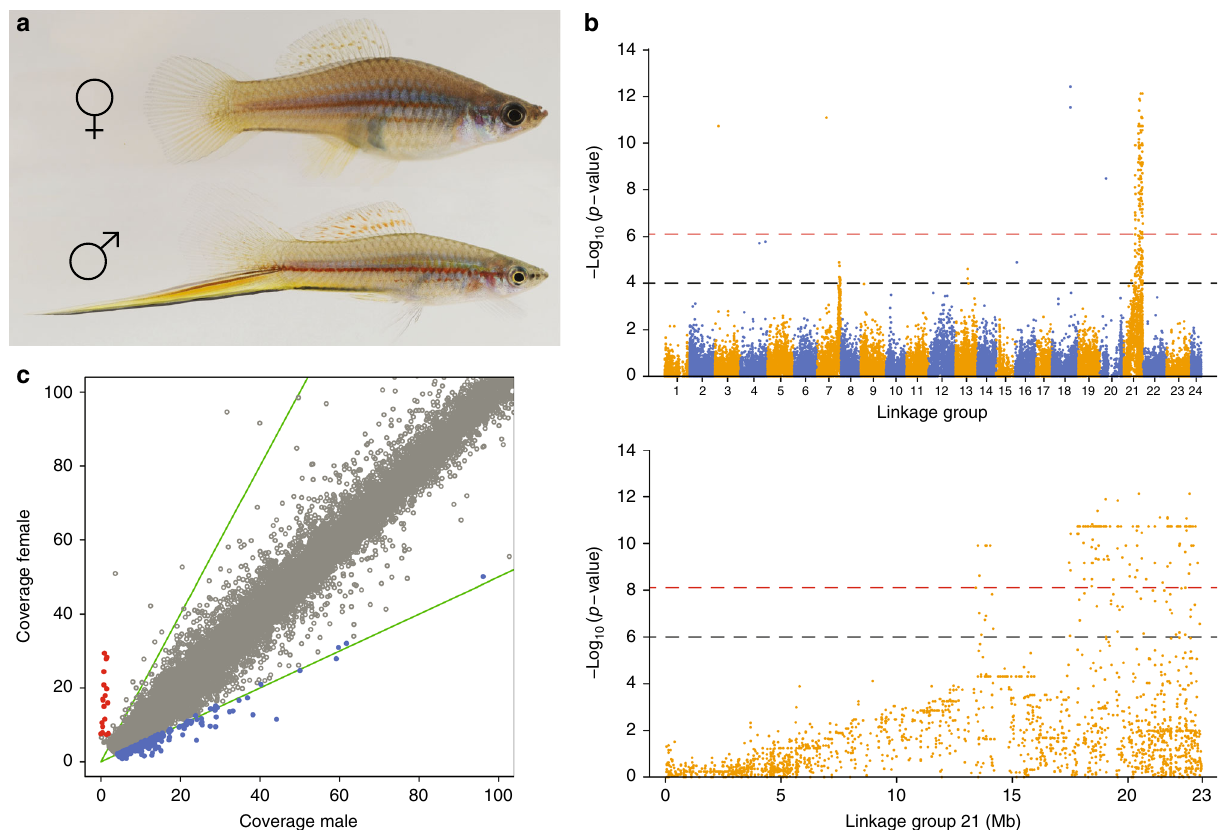
Fig. 2 Sex-determination system in Xiphophorus hellerii . a A male and female specimen of X. hellerii , males are clearly distinguished by the elongated caudal fi n, ‘ the sword ’ (Fish images by M. Schartl). b Genome-wide association analysis, where sex is set as a binary case/control variable. The 65,417 SNPs that passed quality control were used in this analysis. The Manhattan plot shows the − log 10 p -value (Fisher ’ s exact test) of each SNP across the 24 X. maculatus linkage groups (LGs). The dashed red line indicates the genome-wide signi fi cance level ( p -value = 7.79e − 7 ), while a suggestive signi fi cance ( p -value = 0.001) is denoted by the dashed black line. Orange and blue colours are used to distinguish between LGs. The peak showing the strongest association is located on LG21, and is enlarged in the bottom-right section of the panel. c Sequence coverage of RAD loci in female and male X. hellerii individuals. Each dot in the scatter plot represents the average coverage across all males ( x -axis) against the average coverage across all females ( y -axis) for each of the selected RAD loci. Red dots indicate potential W-linked loci (female-speci fi c loci), while blue dots indicate loci potentially linked to the Z chromosome (twice the coverage in males than in females). The upper and lower green lines show the expected coverage of X-linked and Z-linked loci in a XY and ZW sex determination system, respectively. The coverage plot showing the total number of selected loci (average coverage across all individuals >3 and <400) is reported in Supplementary Fig.